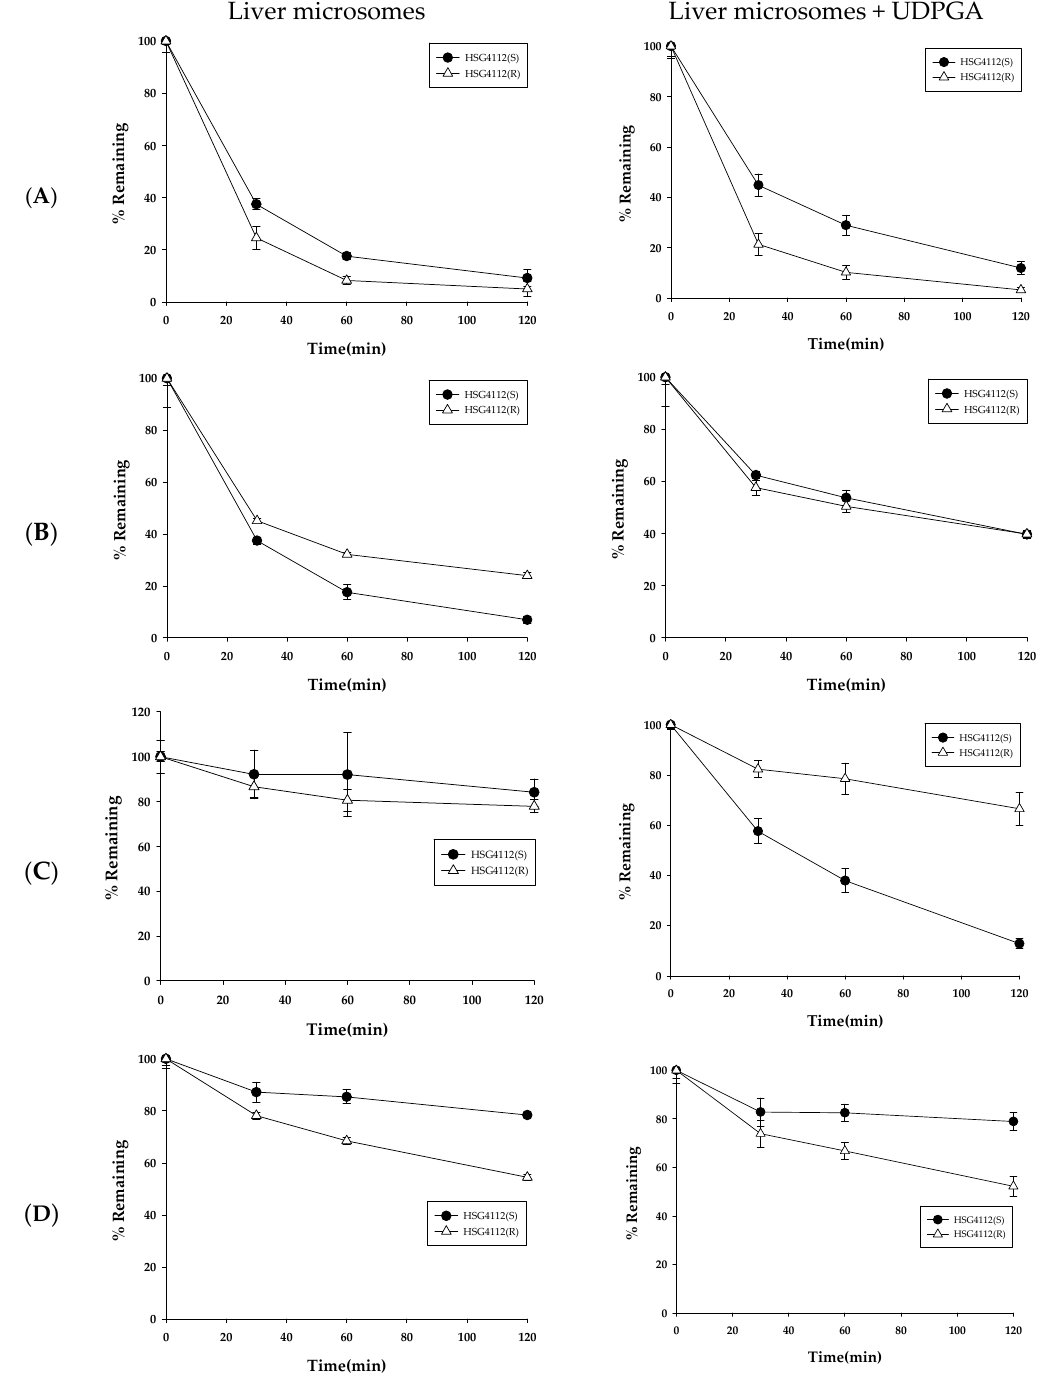
Figure 4. Metabolic stability of HSG4112 in ( A ) rat, ( B ) mouse, ( C ) dog, and ( D ) human liver microsomes ( n = 3). UDPGA, uridine 5 (cid:48) -diphosphoglucuronic